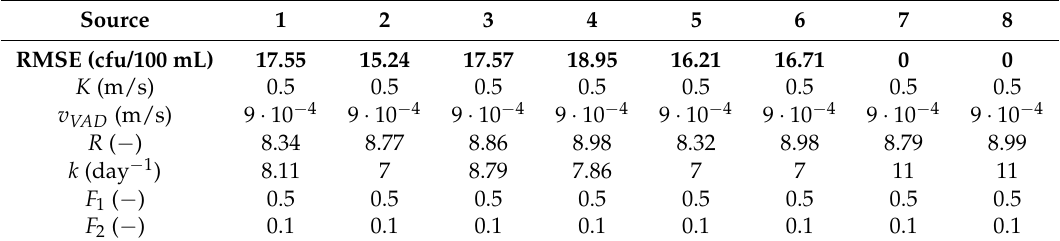
Table 7. Optimal combinations of the variation parameters values with the respective RMSE for each path 1–8 towards B4